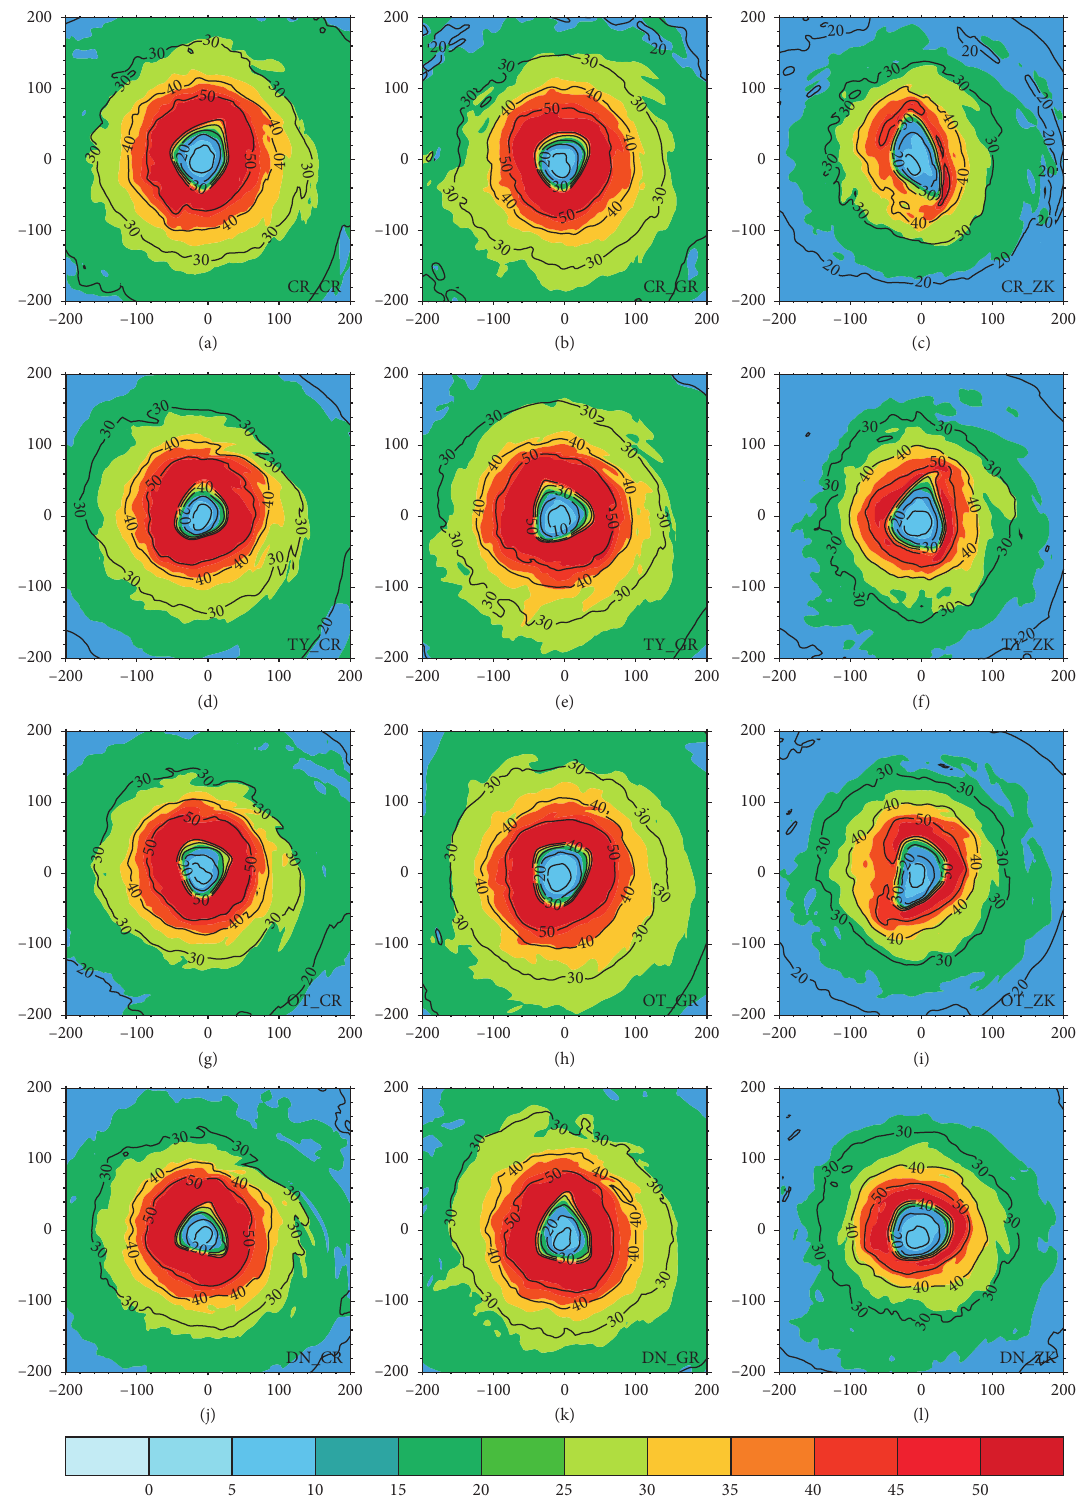
Figure 9: Comparison between enthalpy flux (colors, W/m 2 ) and wind speed at 10m level (black lines, m/s) from 12 experiments at 1200 UTC 27 Oct 2018. Axis denotes the distance (km) from the center of the